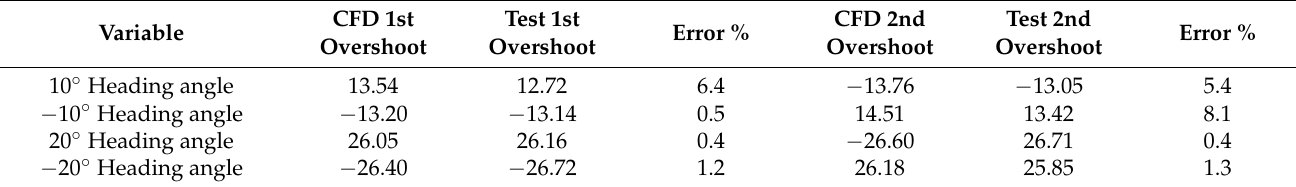
Table 7. Comparison of parameters and characteristics of zigzag